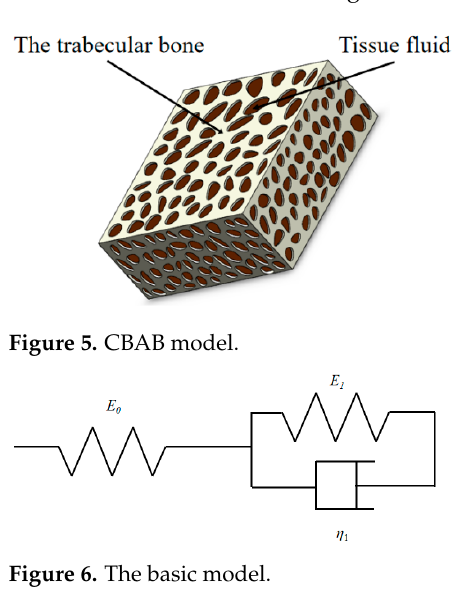
Figure 6. The basic model. Figure 6. The basic